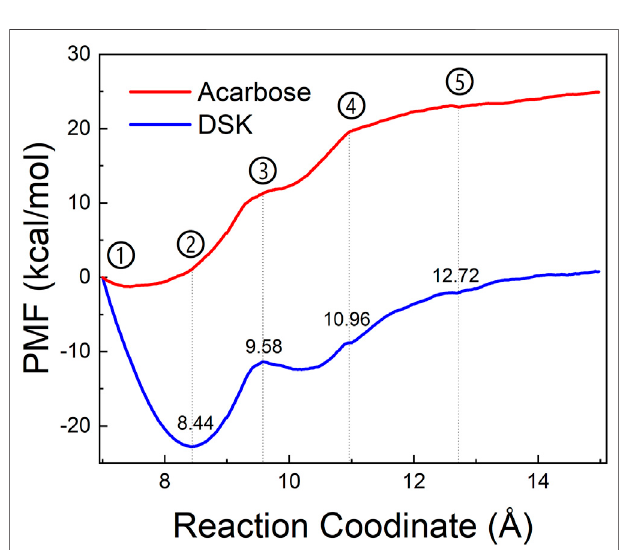
FIGURE 10 | PMF pro fi les along with the reaction coordinates of acarbose-NtMGAM (red) and DSK-NtMGAM (blue).